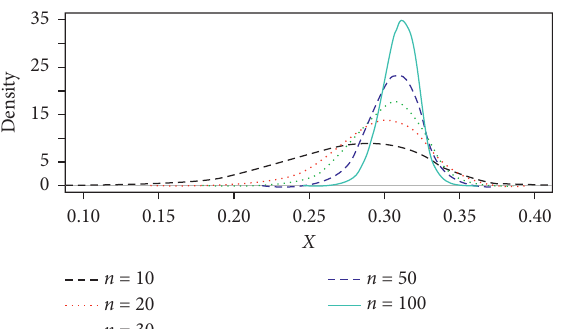
Figure 2: The estimated PDF’s of R 0 . 5